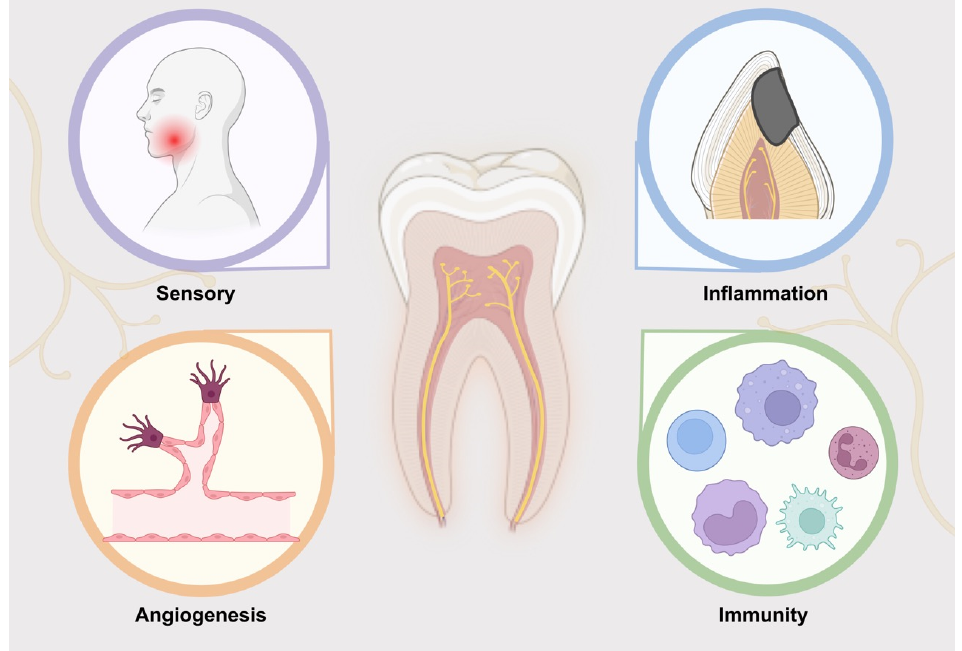
Figure 1. Nerve function in teeth. Nerves participate in sensation, inflammation, angiogenesis, and immunity in the tooth.